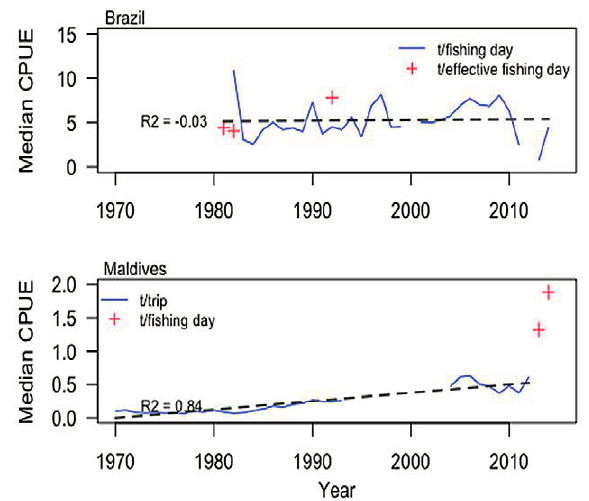
Fig. 7. – Annual median CPUE per studied